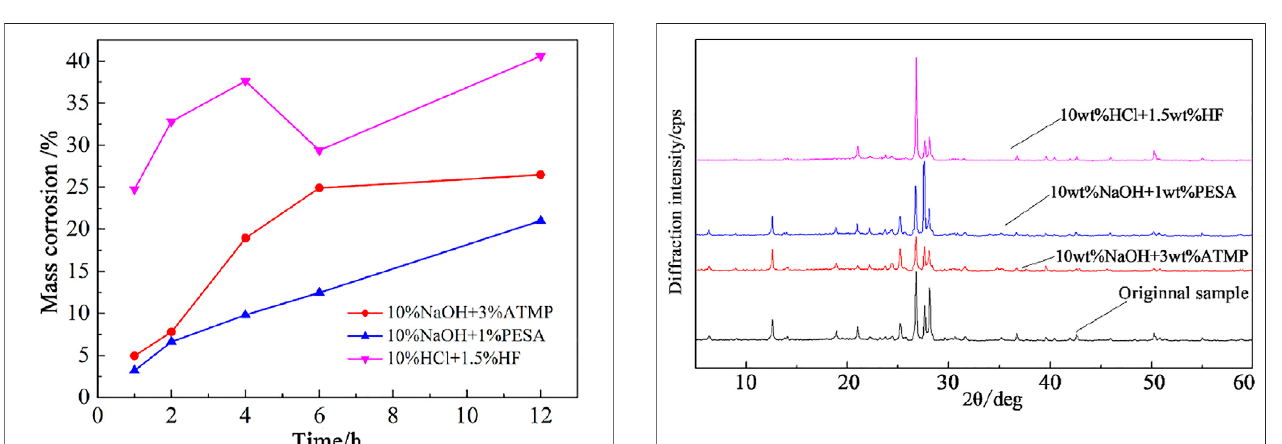
FIGURE 8 | XRD diffraction curves of residual samples after reaction for 12